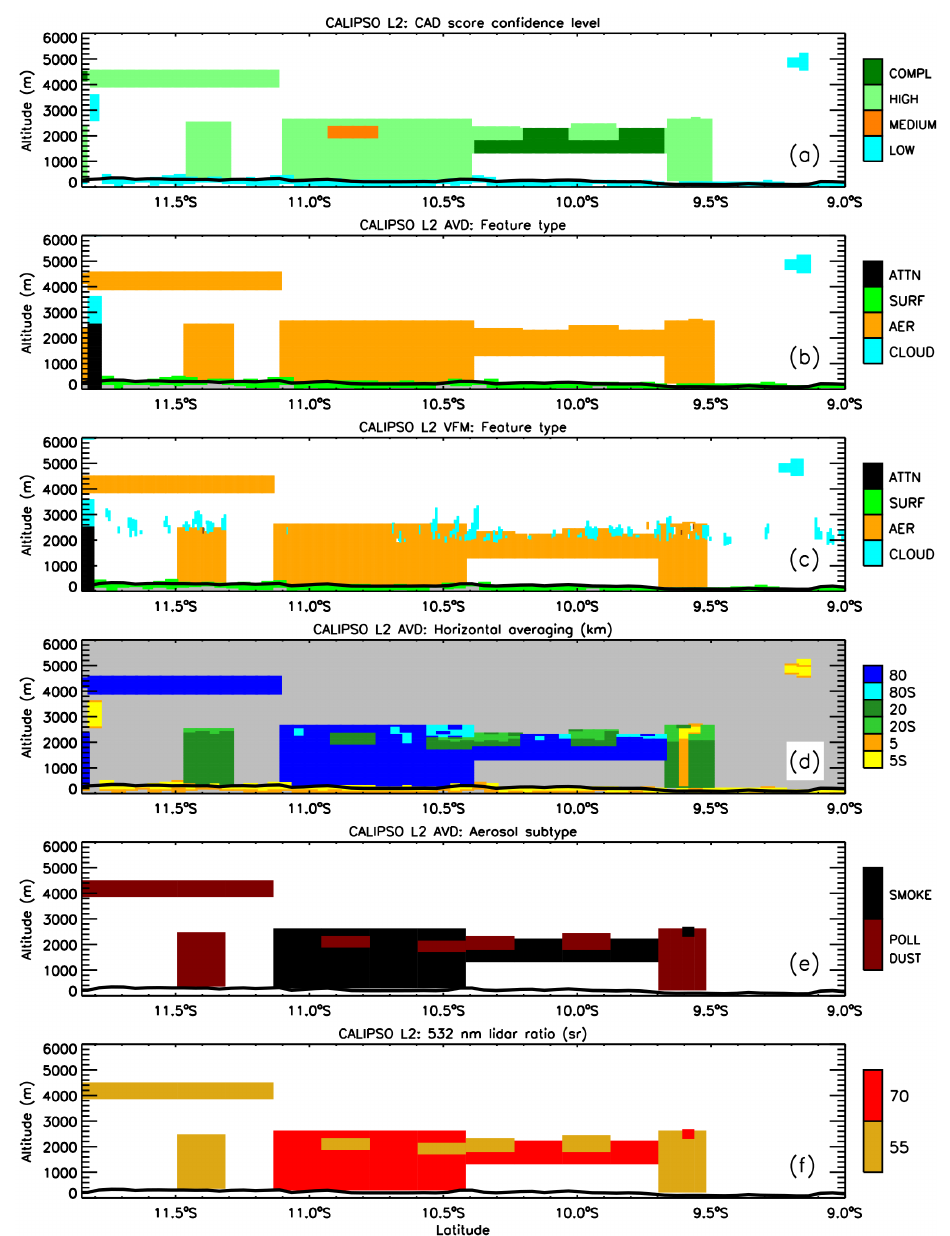
Figure 3. Latitude–height contour plots of some additional quantities determined from the CALIPSO Level 2 data set: (a) CAD score confidence level; (b) Feature type, as provided in the AVD flags; (c) Feature type, as provided in the VFM flags; (d) Horizontal averaging in km, as used for retrievals; (e) Aerosol subtype classification; and (f) Lidar ratio assigned for retrievals. An “S” in the horizontal averaging indicates that subgrid features have been detected at single-shot resolution. CAD score confidence levels are as follows: low, CAD > − 20; medium, − 79 ≤ CAD ≤ − 20; high, − 99 ≤ CAD ≤ − 80; complete, CAD = −